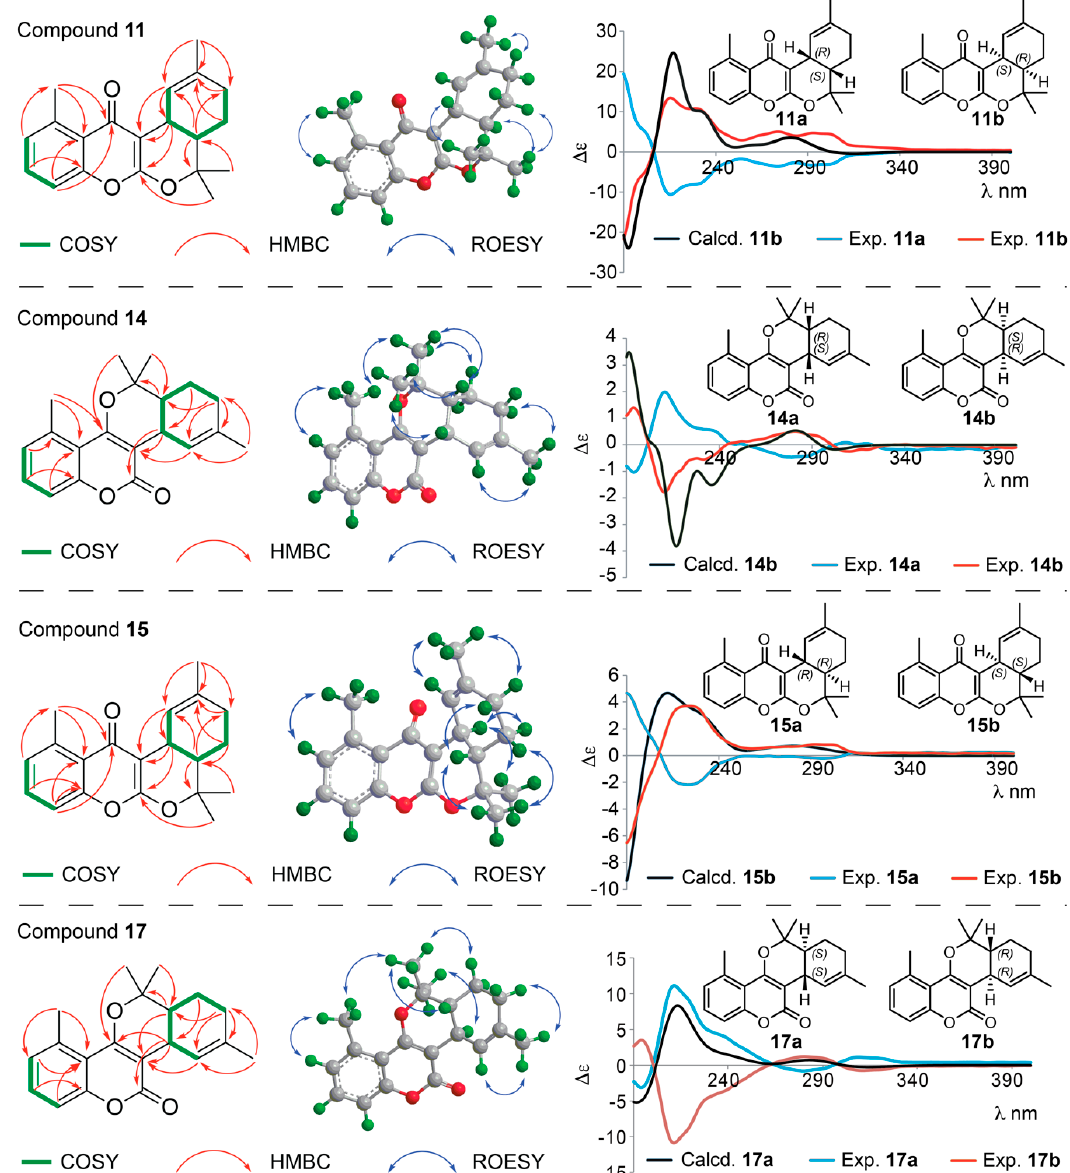
Figure 6. Left : Key COSY and HMBC correlations of 11 , 14 , 15 and 17 . Middle : Key ROESY correlations to establish relative configuration of one of the enantiomers of 11 , 14 , 15 and 17 . Right : Calculated ECD spectra of 11b , 14b , 15b and 17a and experimental ECD spectra of the enantiomers 11a / b , 14a / b , 15a / b and 17a / b . The enantiomeric structures of 11 , 14 , 15 and 17 shown with absolute configuration of the stereocenters determined based on the ECD data.